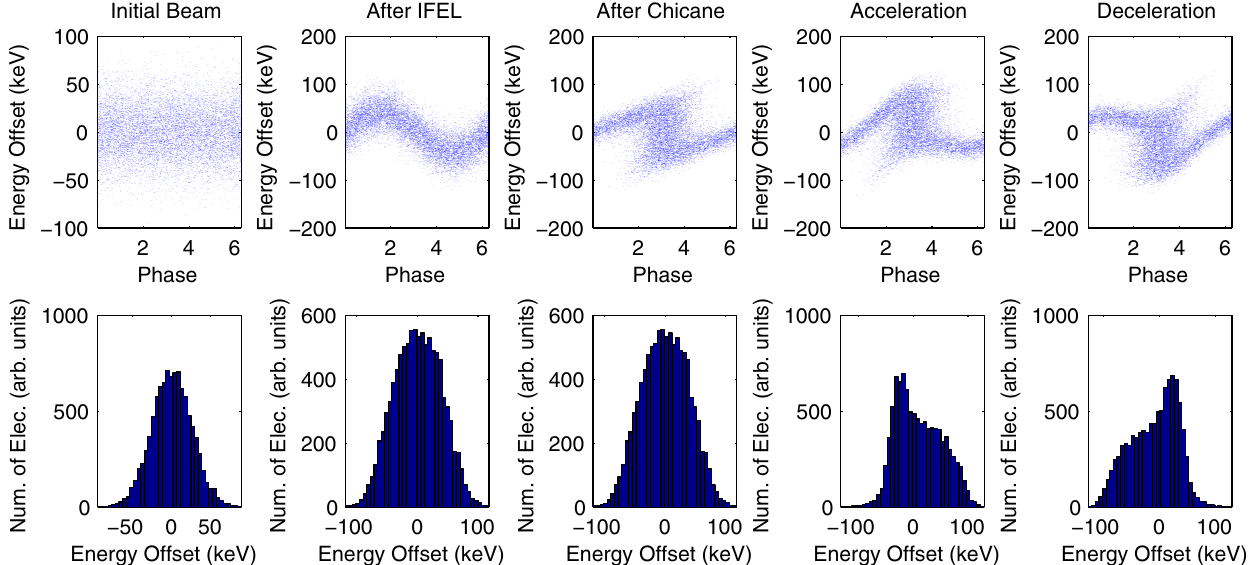
FIG. 1. (Color) Monte Carlo simulation of the evolution of a microbunch in the net acceleration experiment. Shown are the longitudinal phase space (top row) and energy spectrum (bottom row) starting before the IFEL and finishing with accelerating and decelerating cases for the ITR